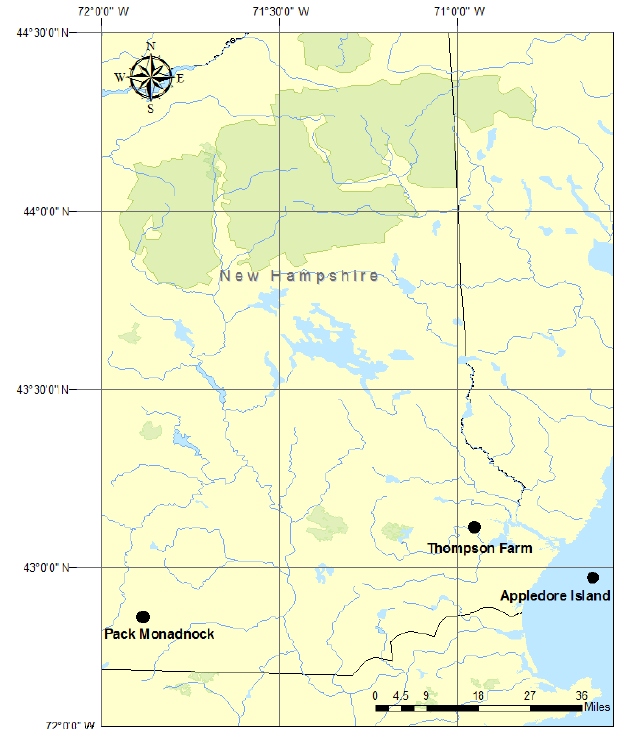
Figure 1. New Hampshire site map: Appledore Island (marine), Thompson Farm (coastal), and Pack Monadnock (inland